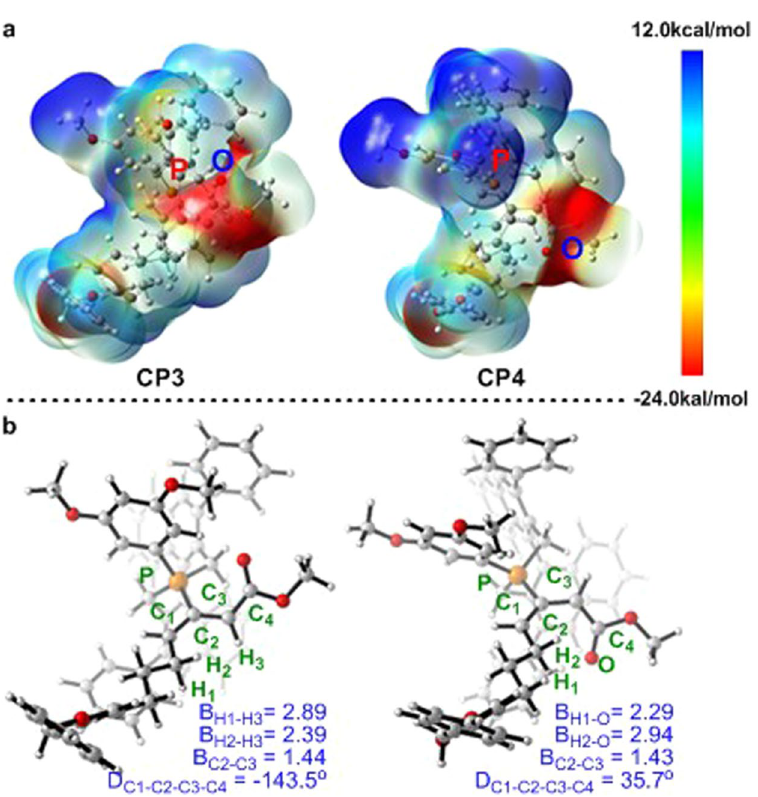
Figure 4. ( a ) Electrostatic potential map for CP3 (left) and CP4 (right). ( b ) Geometries of Intermediates CP3 (left) and CP4 (right). The values of bond lengths are given in